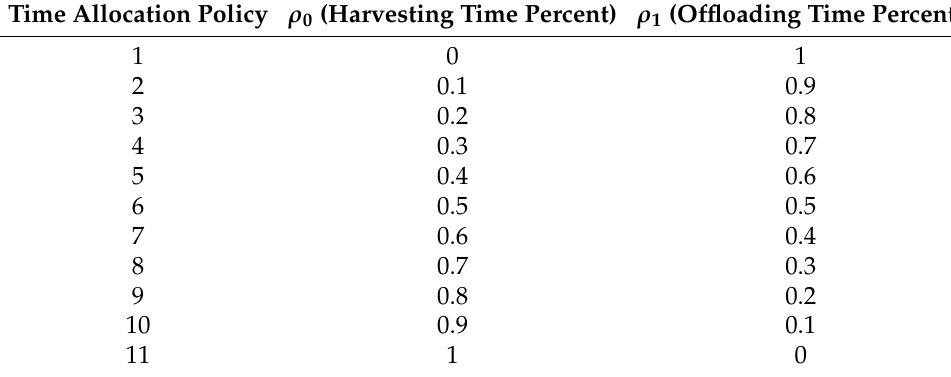
Table 2. Possible time allocation policies, for resolution r s =